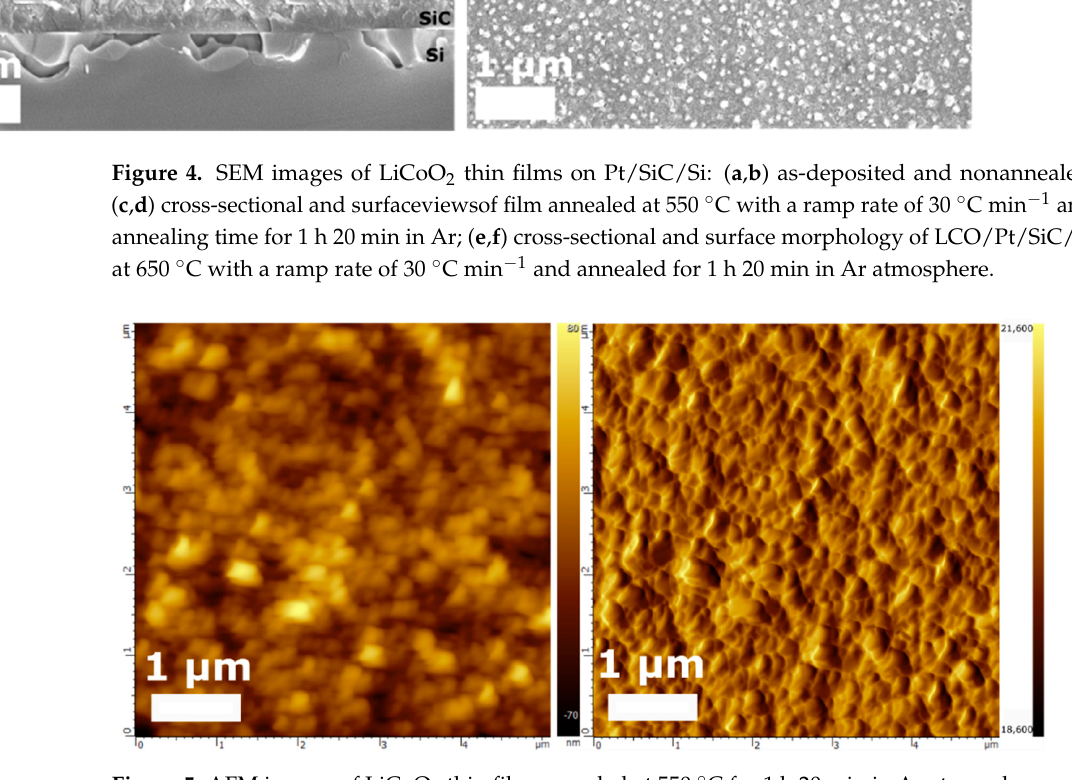
Figure 6. CV scans of LiCoO 2 thin-film cathodes annealed in Ar: ( a ) 550 °C for 1 h 20 min at ramp rate of 30 °C min − 1 ; ( b ) 550 °C annealed for 2 h at 30 °C min − 1 ; ( c ) EIS for 550 °C for 1 h 20 min at ramp rate of 30 °C min -1 before cycling at discharge state . In order to understand the kinetics properties, EIS scans were measured for the crystalline thin film before cycling, as shown in Figure 6c. A semicircle represents the charge transfer process across the interface between the electrode and the electrolyte. The charge transfer resistance of the LiCoO 2 cathode film annealed at 550 °C made at near 115 Ohm favored fast Li ion diffusion. The potential profiles and cycling performance are given in Figure 7. As can be seen in Figure 7a,b, the two initial formation cycles were performed at 0.1 C rate followed by